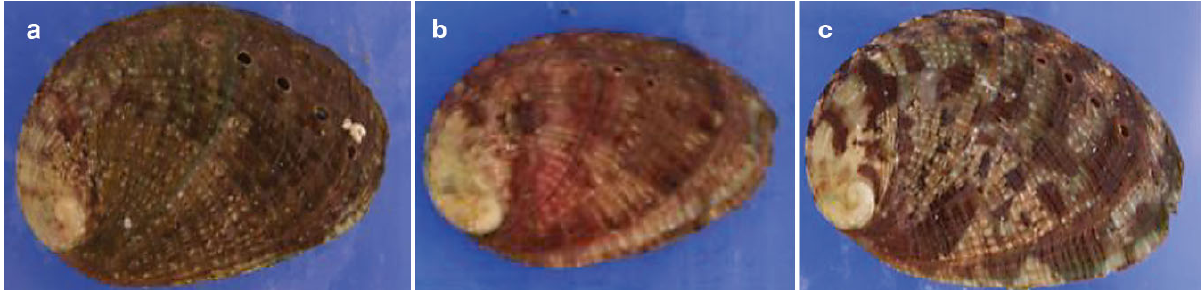
Fig. 1. Shell patterns of abalone with (A) homogenous colour, (B) discolouration in one part of the shell and (C) stripes on at least one-third of the